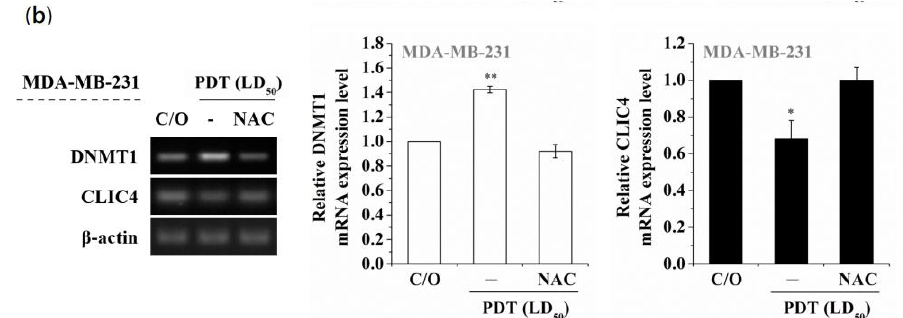
Figure 3. Scavenging ROS production suppresses the PDT-induced increase of DNMT1 and con- strains the following CLIC4 suppression. Cells were co-incubated with both 1 mM ALA and 5 mM NAC for 3 h and then exposed to specific wavelength (635 ± 5 nm) of light, 2 J/cm 2 and 4 J/cm 2 for ( a ) A375 and ( b ) MDA-MB-231 cells, respectively. Total RNA samples were isolated from PDT-treated cells 24 h after ALA-PDT to analyze the mRNA expression level. The relative mRNA expression level of each gene was measured by RT-PCR and normalized to β -actin. The control group was cells only treated with ALA w/o light irradiation. The same volume of each PCR product was loaded, and band blots for each gene were cropped from different gels. Data represent from three independent experiments. Each bar shown is the mean fold change relative to control ± SD. Results are considered to be statistically significant at * p < 0.05 and ** p < 0.01.